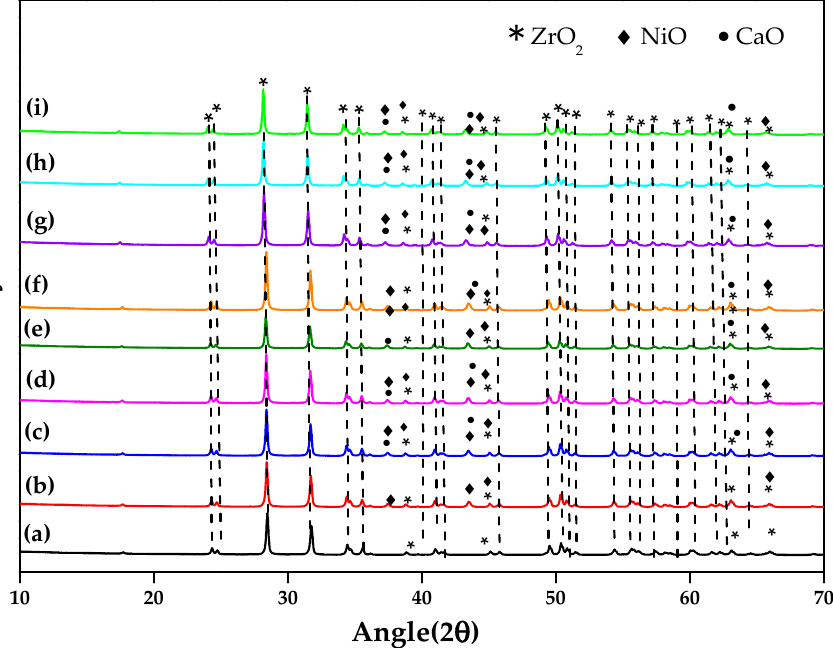
Figure 1. XRD spectra of ( a ) ZrO 2 , ( b ) 10%Ni/ZrO 2 _WI, ( c ) 10%Ni-0.5%Ca/ZrO 2 _WI, ( d ) 10%Ni- 3%Ca/ZrO 2 _WI, ( e ) 10%Ni-5%Ca/ZrO 2 _WI, ( f ) 10%Ni/ZrO 2 _Us, ( g ) 10%Ni-0.5%Ca/ZrO 2 _Us, ( h ) 10%Ni-3%Ca/ZrO 2 _Us, and ( i ) 10%Ni-5%Ca/ZrO 2 _Us catalysts. Table 1. Specific surface area, pore volume, and pore size of the synthesized catalysts. Specific Surface Catalyst Area (m 2